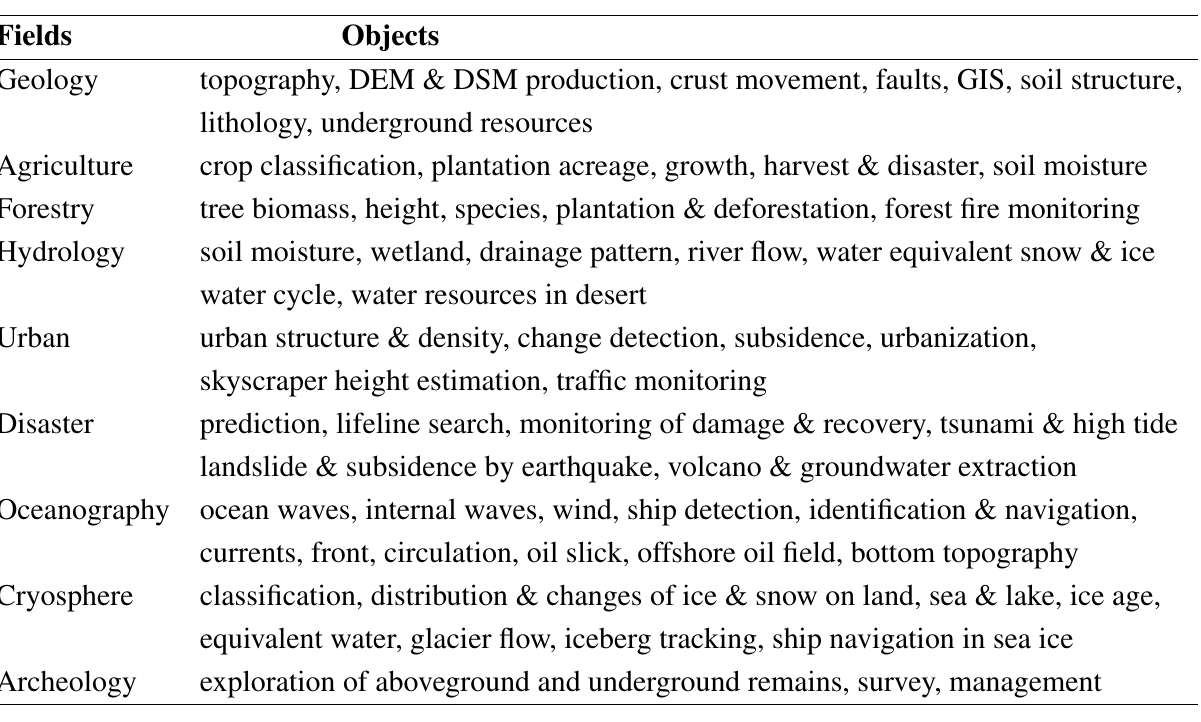
Table 1. Selected fields of SAR application examples. Note that not all applications are in practical use; many applications are still at developing